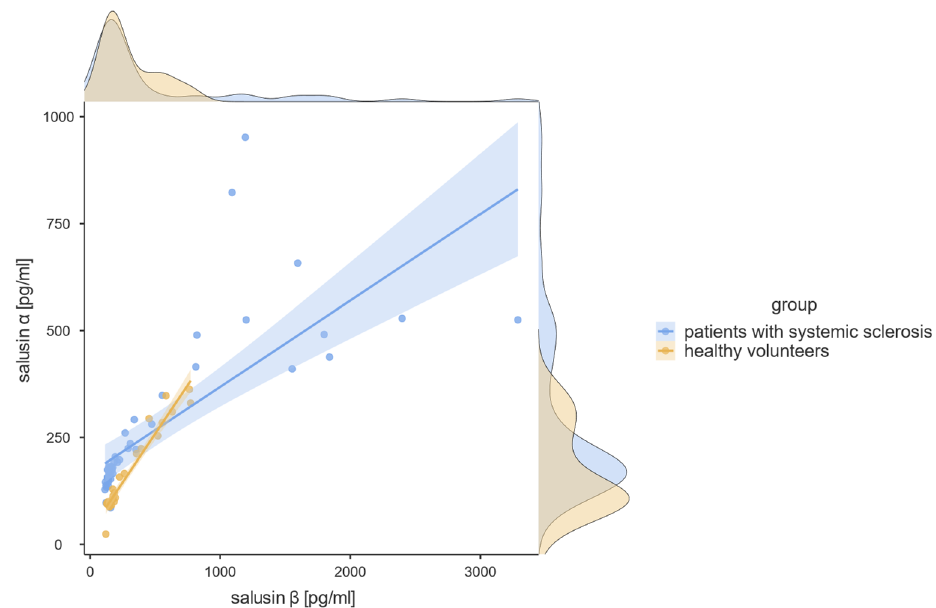
Figure 2 . Simple linear correlation between salusin- α and β concentrations [pg/mL]. Statistically significant linear regression results were found . ( a) for all patients: F(1, 70) = 94.56; p < 0.001; R 2 = 0.57, (b) for the systemic sclerosis group: F(1, 45) = 54.81; p < 0.001; R 2 = 0.55, (c) for the healthy volunteers: F(1, 23) = 326.64; p < 0.001; R 2 = 0.93.